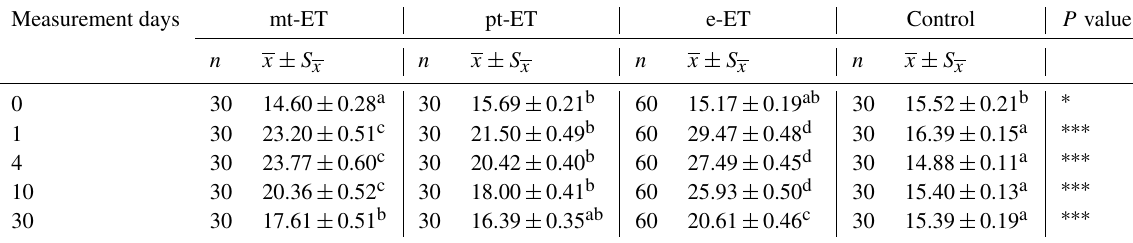
Table 2. Least-squares means ( ± SE) for the infrared ear temperatures of lambs on days 0, 1, 4, 10, and 30 ( ◦ C). Measurement days